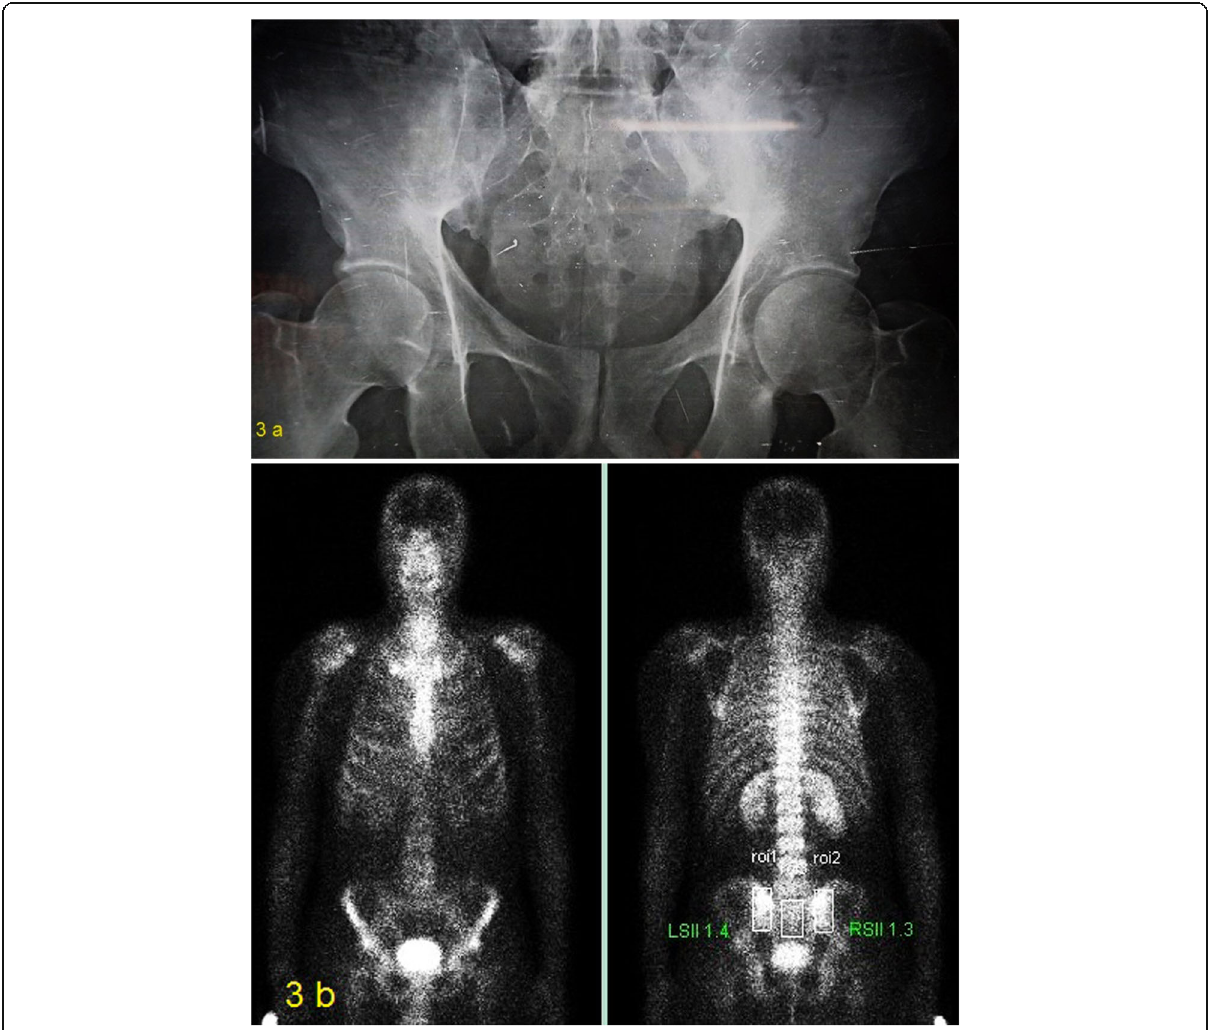
Fig. 3 Thirty-three years old male with ankylosing spondylitis. a X-ray radiography of sacroiliac joints (AP view) reveals sclerosis, irregularity, and narrowing of the RT SIJ and fused LT one. b Tc-99 m MDP whole-body bone scintigraphy (anterior and posterior views) shows increased uptake of both sacroiliac joints (right SII = 1.3, left SII =